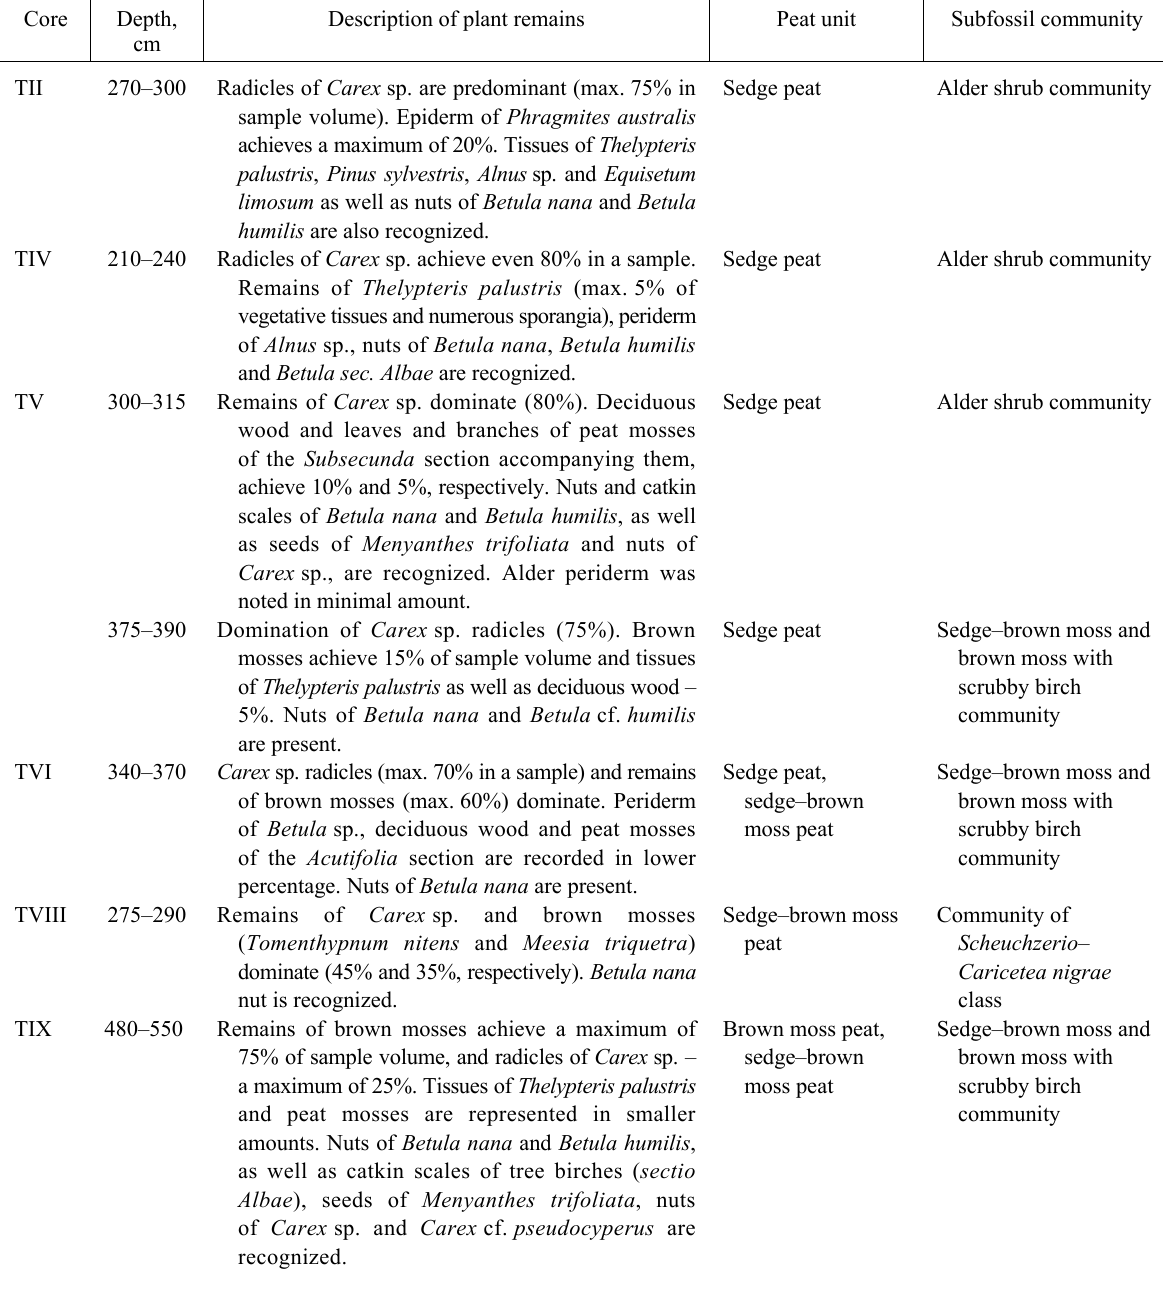
Table 2. Description of the botanical composition of peat layers containing remains of B. nana and designation of peat units and subfossil plant